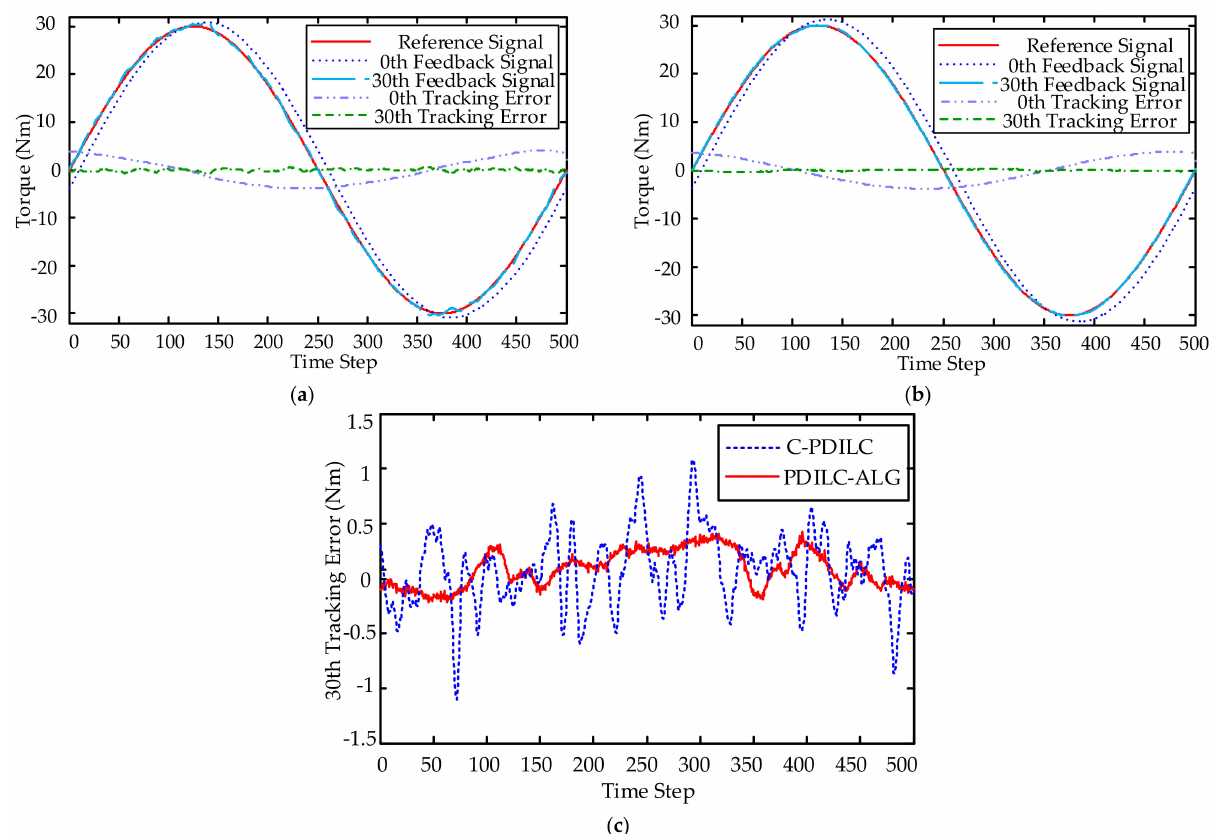
Figure 8. Case 1 experimental results ( θ ∗ a ( t ) = 8 ◦ sin ( 2 π ih ) , y d ( t ) = 30sin ( 2 π ih ) ): ( a ) Loading torque trajectory tracking with the conventional PD-type iterative learning control at the 0th and 30th iterations. ( b ) Loading torque trajectory tracking with the PD-type iterative learning control with adaptive learning gains at the 0th and 30th iterations. ( c ) The comparison of the loading torque tracking errors at the 30th